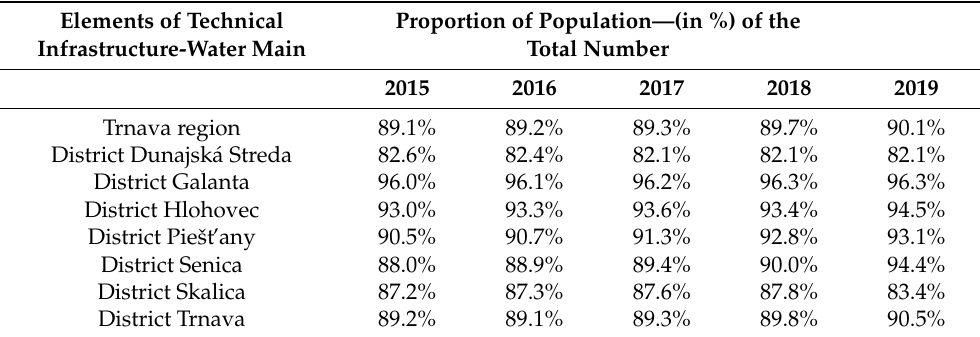
Table 5. Population with elements of technical infrastructure (water main) in Trnava region.